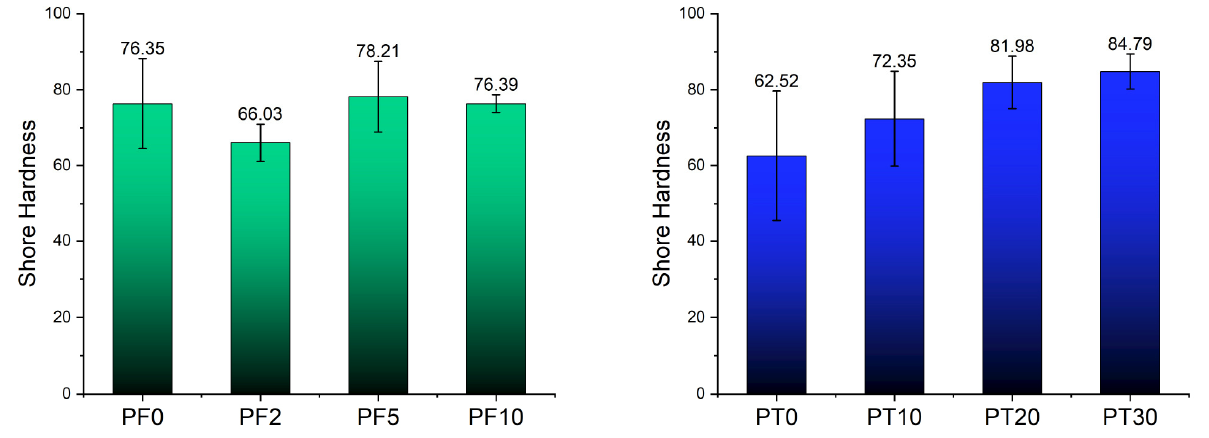
Figure 4. Variation of Shore hardness on PF ( left ) and PT ( right ) samples.